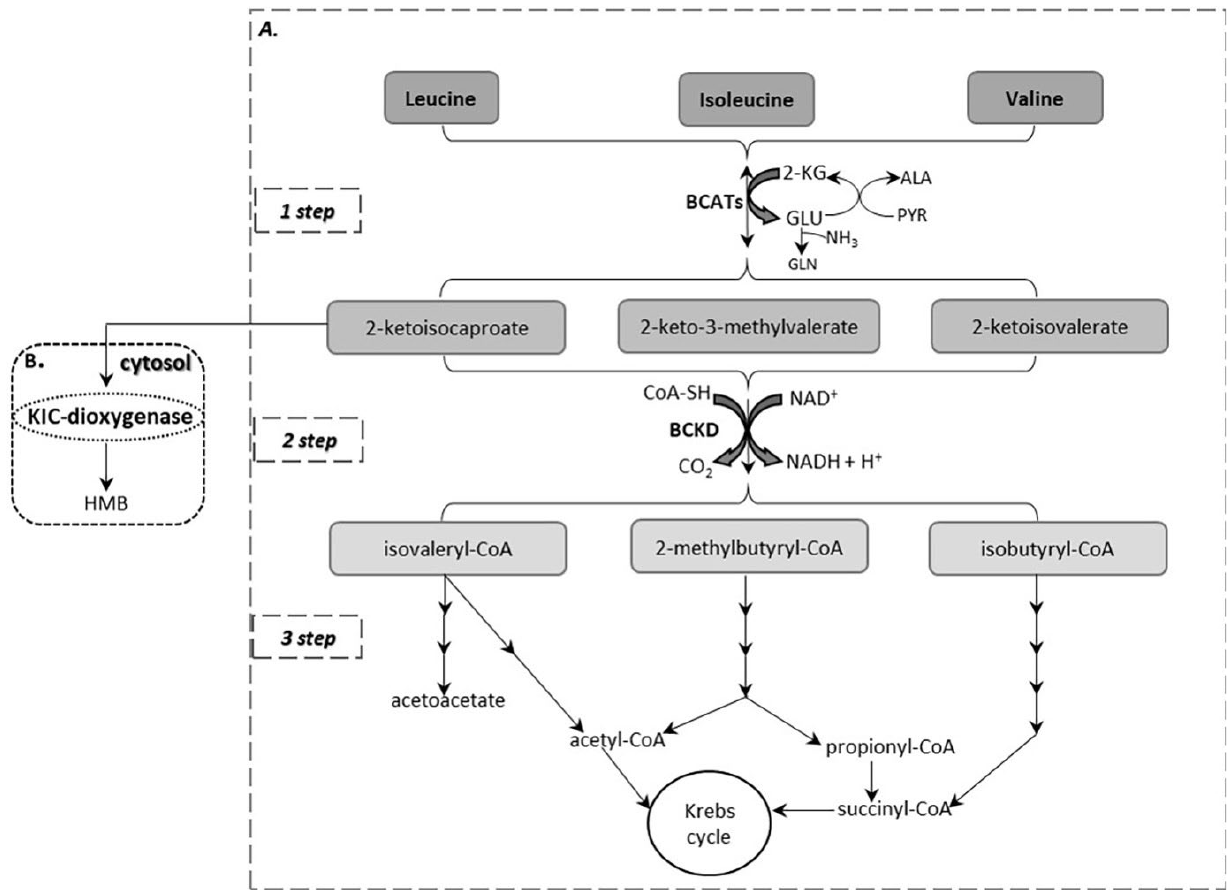
Figure 1. ( A ) BCAA catabolism. ( B ) An alternative pathway of leucine catabolism in the cytosol of the liver.